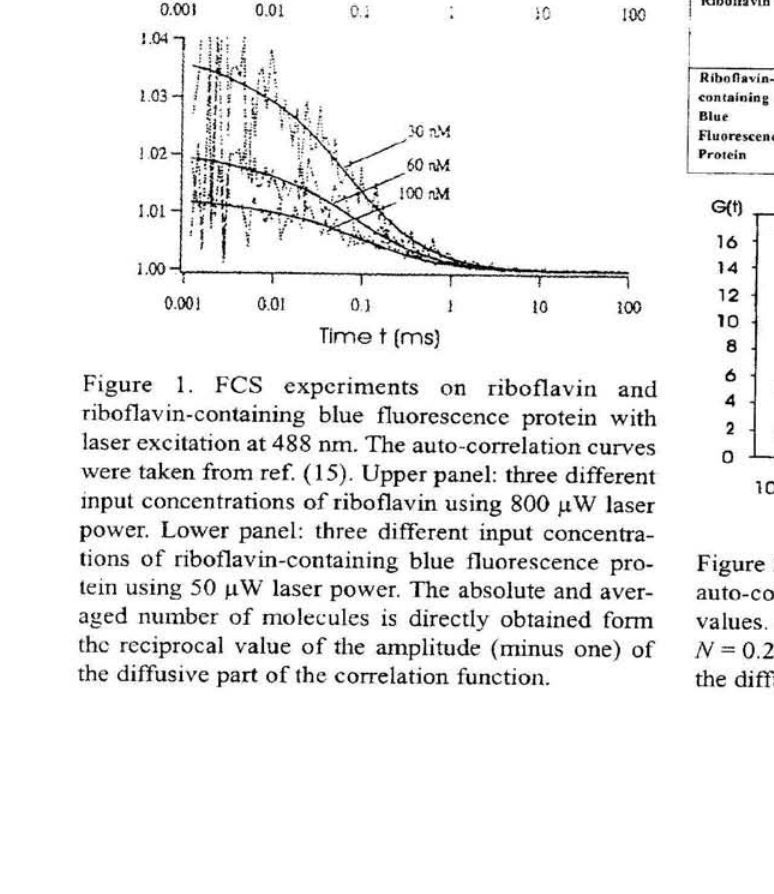
Tab le 1. FCS experiments on riboflavin and blue flu- orescence protein recombined (labeled) with riboflavin. All data were taken from Table 2.2 of ref. (15). All parameters, except the number of molecules Ν and the relative fraction, were linked in a global analysis of six experiments (15). The values in paren- thesis were obtained at the 67% confidence level. The observation (detection) volume ΔΥ was measured with the dye Oregon Green to be 1.3 fl (femtoliter).